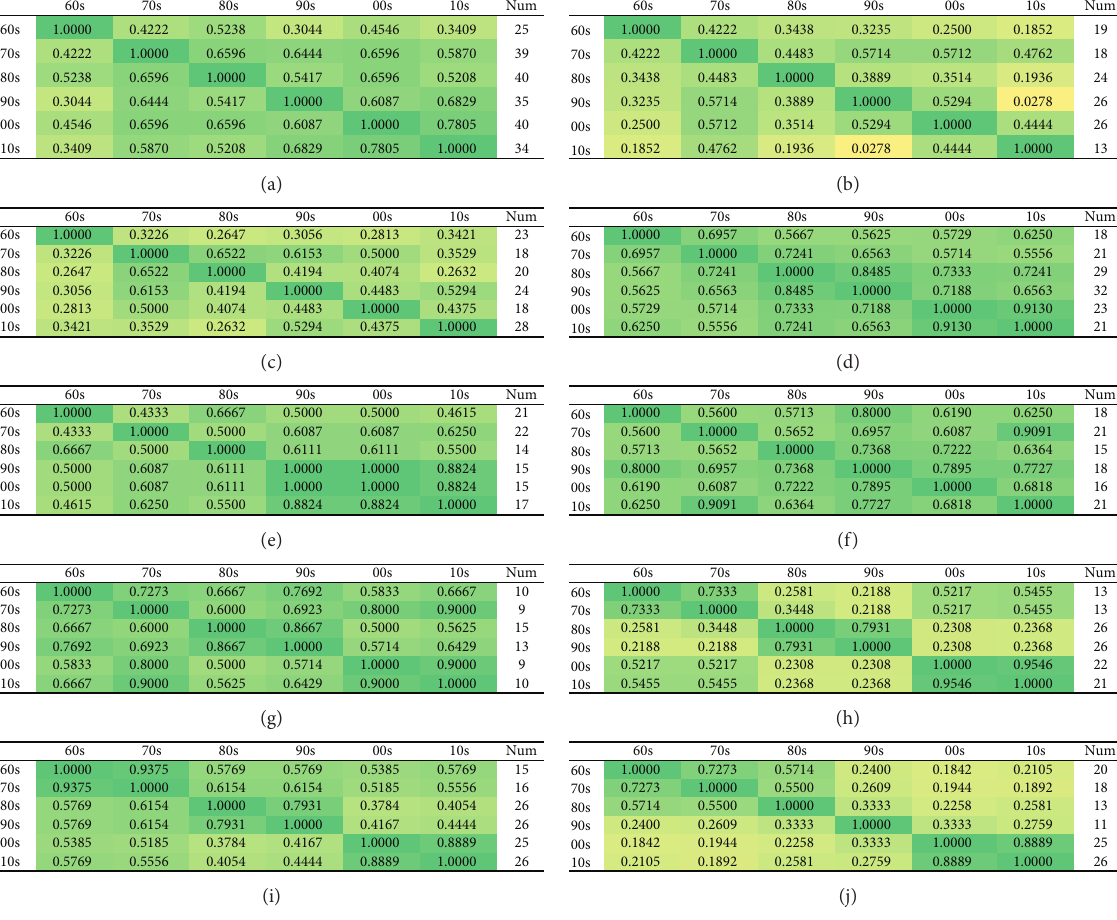
Figure 10: Jaccard similarity coefficients of ten typical communities for different time periods. “Num” means the number of members in the corresponding community. (a) Group 1, America. (b) Group 2, French related. (c) Group 3, British Commonwealth. (d) Group 4, Indian Ocean. (e) Group 5, East-Middle Africa. (f) Group 6, Western Africa. (g) Group 7, Southern Africa. (h) Group 8, Europe. (i) Group 9, the former Soviet Union. (j) Group 10, East